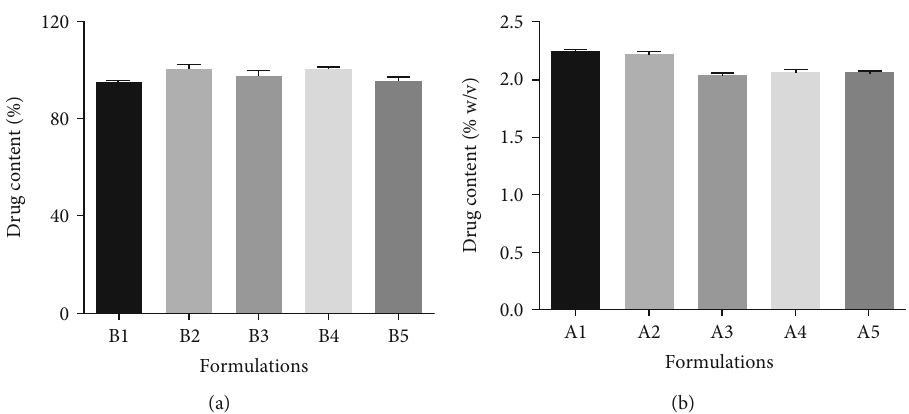
Figure 2: Drug content of formulations: (a) paracetamol syrups; (b) simple linctus (values are mean ± standard deviation , n = 3